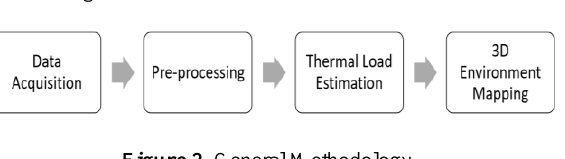
Figure 2. General Methodology